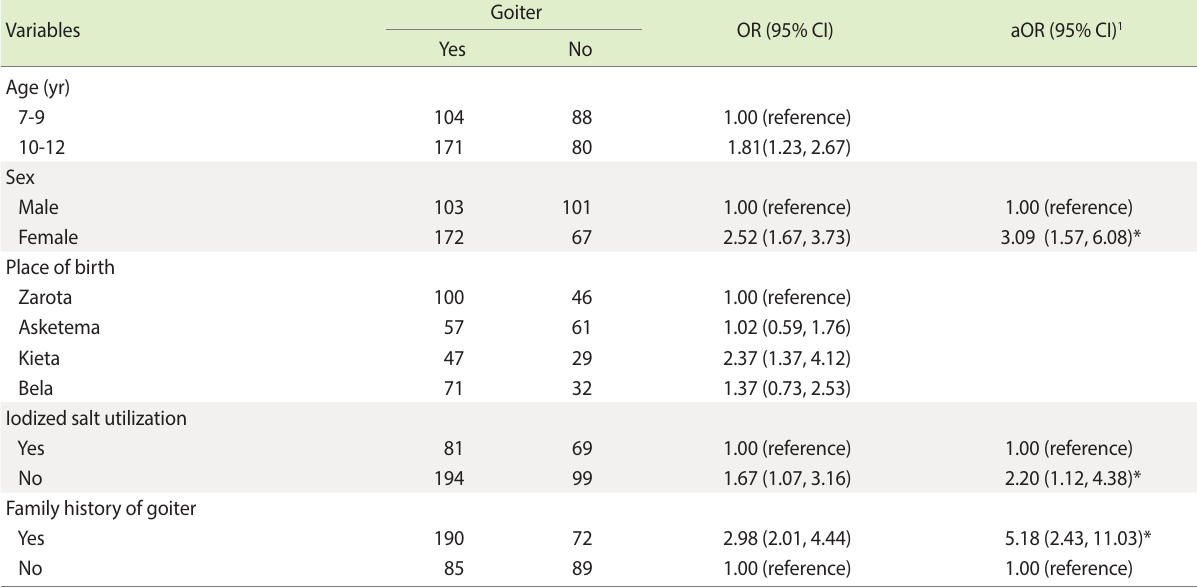
Table 4. Factors associated with goiter among schoolchildren, Gasgibla woreda , Waghimra Zone, northeast Ethiopia, 2015